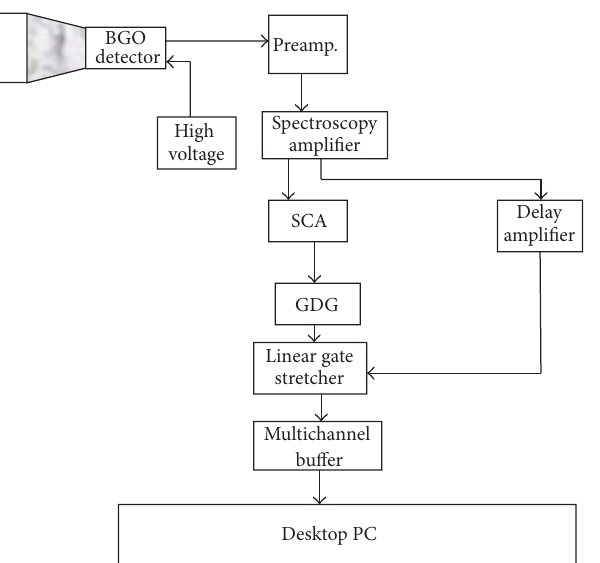
Figure 6: Electronics block diagram used to suppress the lower energy part of the BGO detector spectrum.